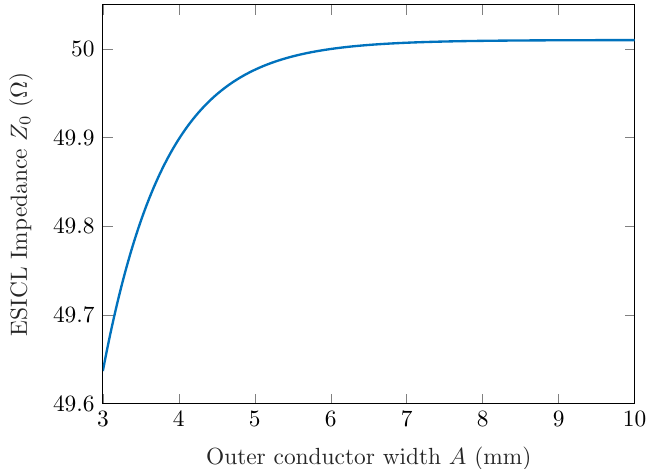
Figure 4. Variation of the impedance ( Z 0 ) of the ESICL as a function of the outer conductor width. B = 2.618 mm, w = 2.2823315 mm, t = 0.866 mm. The analytic formula of Equation (5) was